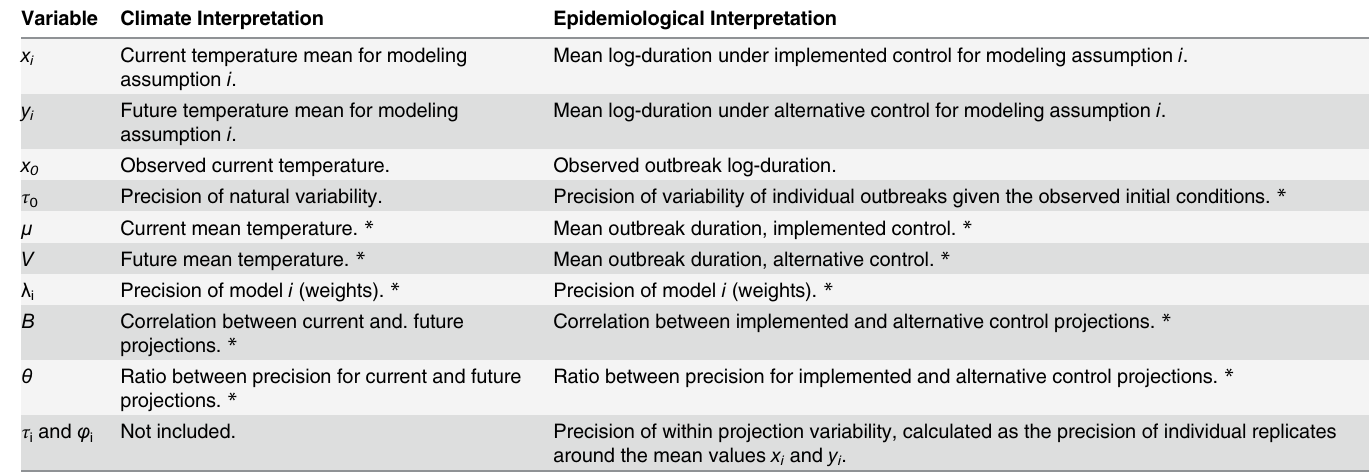
Table 2. Variables in the NHW analysis with the interpretation for the original climate interpretation and the epidemiological